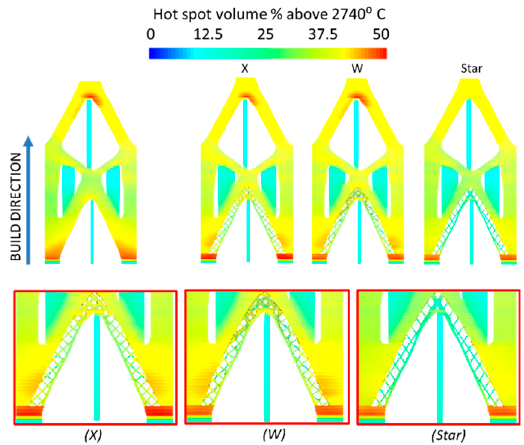
Figure 10. Comparing the hotspot observed in the optimized domain and the lattice introduced optimized domains using the ‘X’, ‘W’ and ‘Star’ lattices. The insets in (X), (W) and (Star) shows the effect of the different lattices on the hotspots.